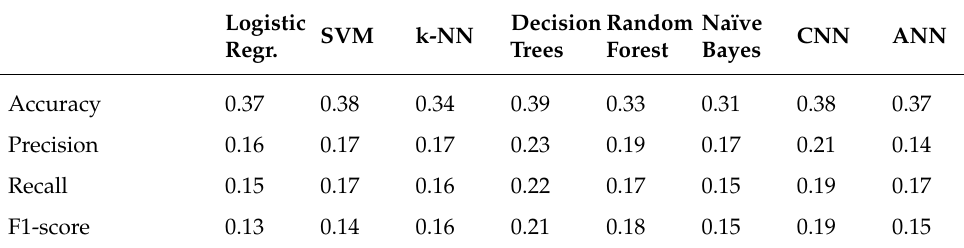
Table 6. The performance metrics of the 11 × 11 confusion matrix for each applied algorithm.